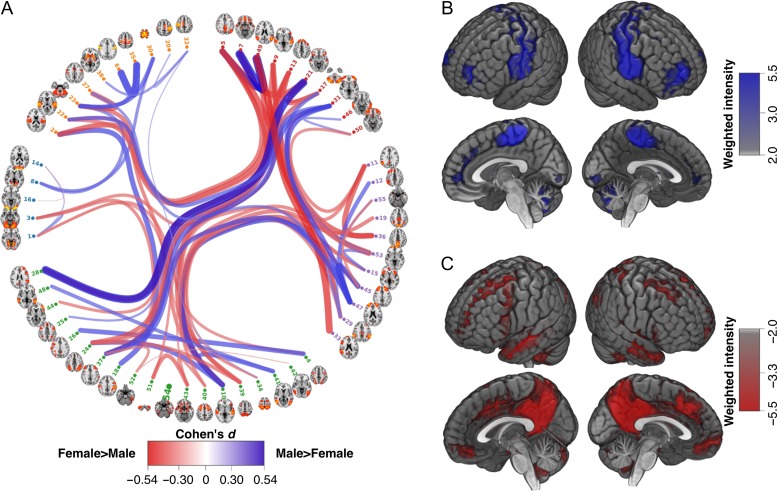
Results for resting-state fMRI connectivity and weighted degree of nodes. (A) Spatial maps for individual connections. Colors and line thickness represent the effect sizes of sex on the strength of connections (red = stronger in females; blue = stronger in males; darker/thicker = larger effect size). Only effect sizes (Cohen’s d) larger than ±0.2 are shown. Nodes were clustered into 5 categories using FSLnets based on their group-mean full-correlation matrix (yellow/orange: sensorimotor network; red: default mode network; purple: salience network and executive control network; green: dorsal attention network; blue: visual network). (B) and (C) Weighted degrees of nodes with higher values in males and females, respectively. The spatial maps of significant group-ICA nodes were multiplied by the effect size of the sex correlation. In order to show the regions with the largest associations with sex, only regions that had intensity over 50% of the whole-brain peak value are presented. See Table S14 for values for each connection and for each node’s weighed degree.